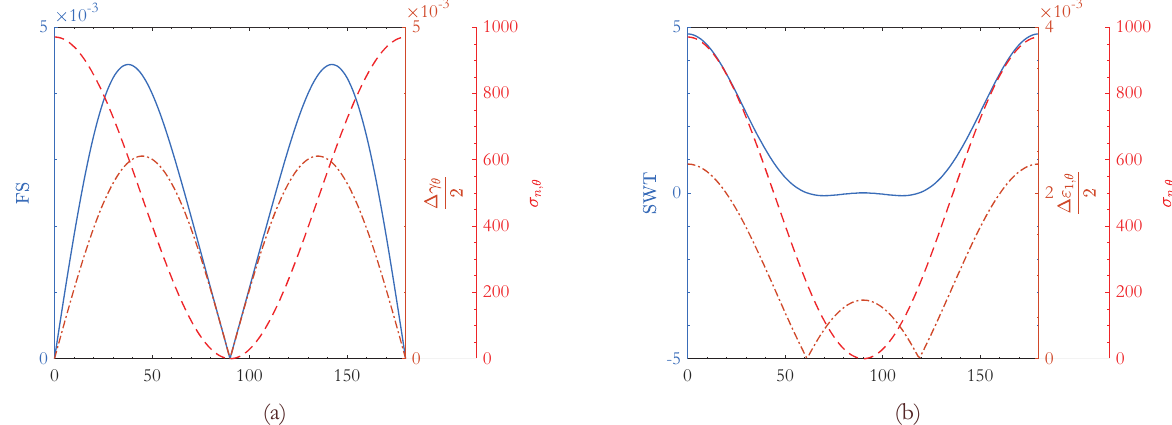
Figure 3: (a) Evolution of Fatemi-Socie parameter (FS), Δγ /2 and σ n as a function of angle θ for proportional loading. (b) Evolution of Smith-Watson-Topper parameter (SWT), Δε 1 /2 and σ n as a function of angle θ for proportional